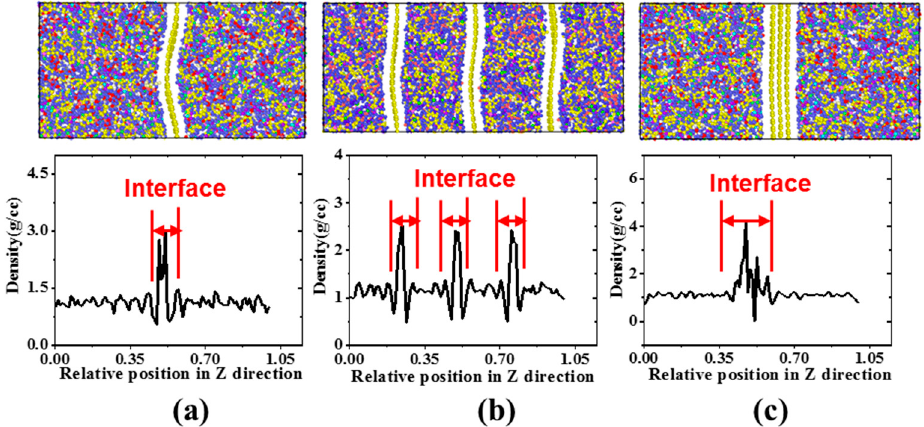
Figure 5. The density of Gr/epoxy nanocomposite along the z direction for (a) single Gr, (b) dispersed Gr and ( c ) aggregated Gr and (c) aggregated Gr.